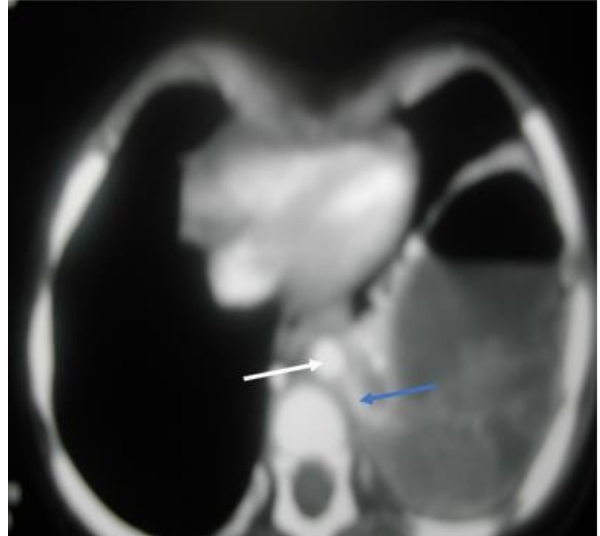
Figure 4. CT chest, axial window, mediastinal view: large, thick wall cavity filled with air fluid with heterogenous opacity. The white arrow shows a descending aorta, while the blue arrow confirms a large feeding vessel to the left lower lobe, a rising and descending aorta, mild compression of left upper lobe, and a mild pectus excavatum.